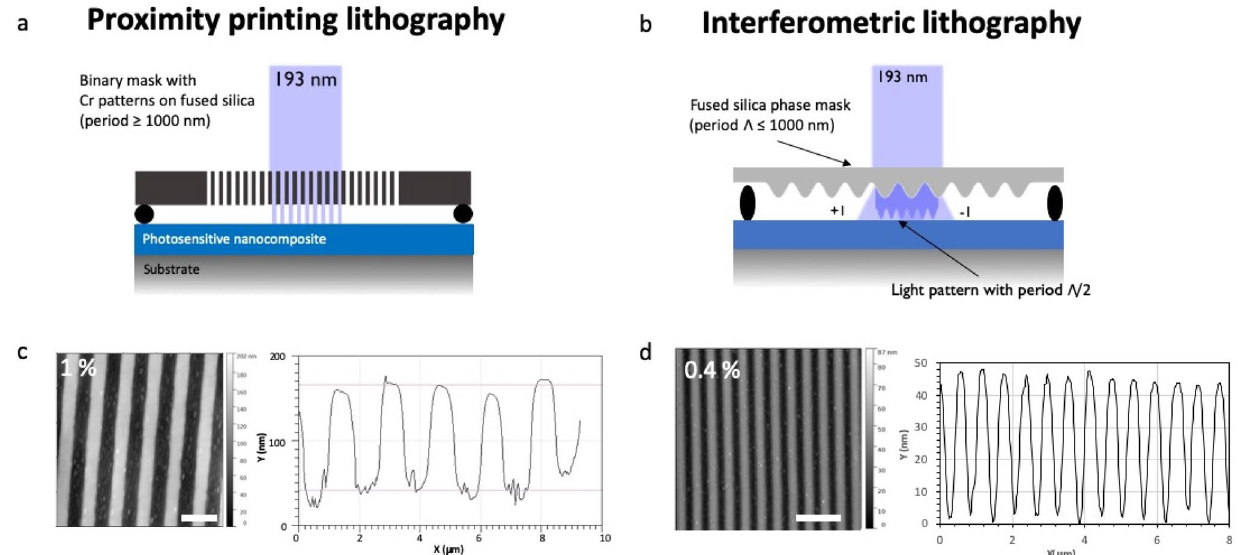
Figure 6. Schematics of the photopatterning setups used in this study: ( a ) proximity printing and ( b ) interferometric lithography. AFM images and cross-sections of typical examples of structures obtained in ( c ) proximity printing (period: 1600 nm, width of structures: 800 nm, height: 125 nm, MNP: 1 vol%) and ( d ) interferometric lithography (period: 600 nm, width of structures: 300 nm, height: 50 nm, MNP: 0.4 vol%). Scale bars are 2 μm in each AFM